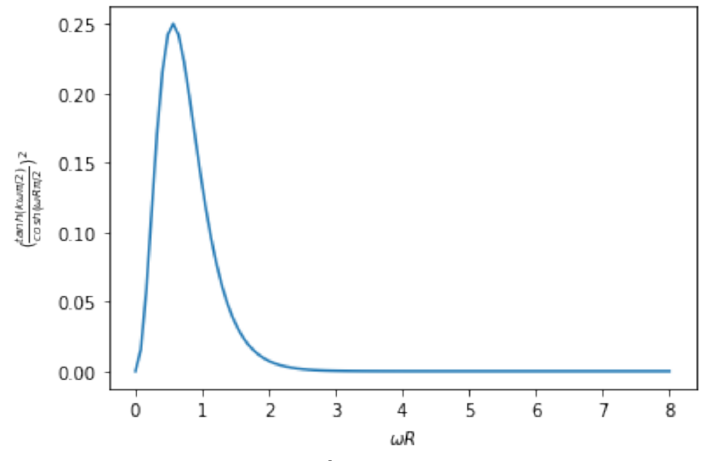
Figure 2 . Plot of the function and is exponentially suppressed for ωR (cid:29) 1